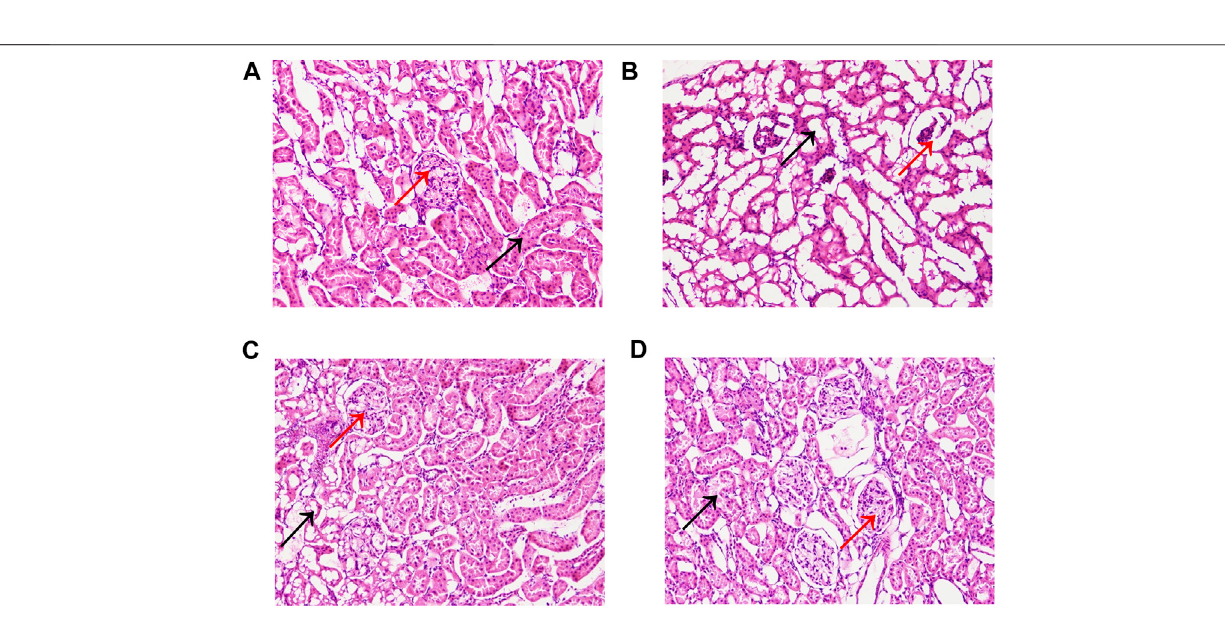
Frontiers in Pharmacology |